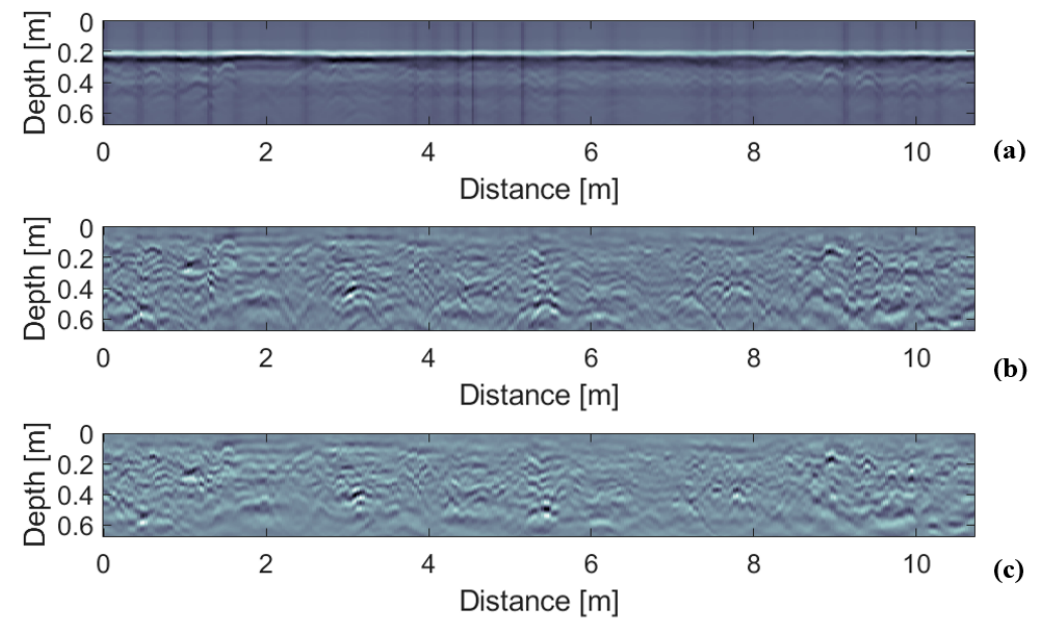
Figure 7. B-scan ( a ) before the application of the preliminary signal processing stage, ( b ) after the application of standard signal processing and SVD filter, and ( c ) after the application of the F–K migration.